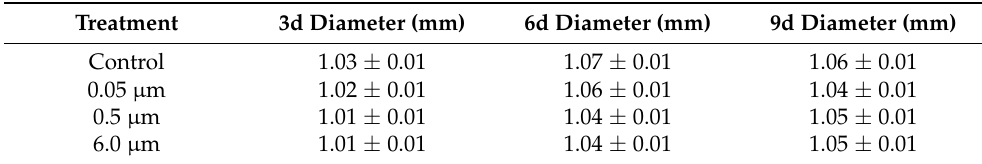
Table A2. Effects of PS-MPs of different sizes on embryo diameter (n =